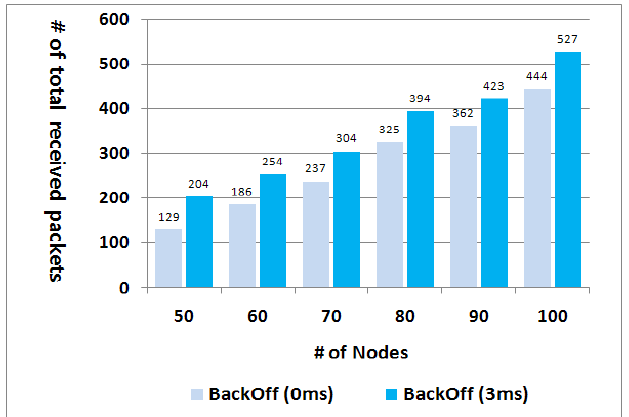
Figure 9. Effect of the back-off delay on the number of received